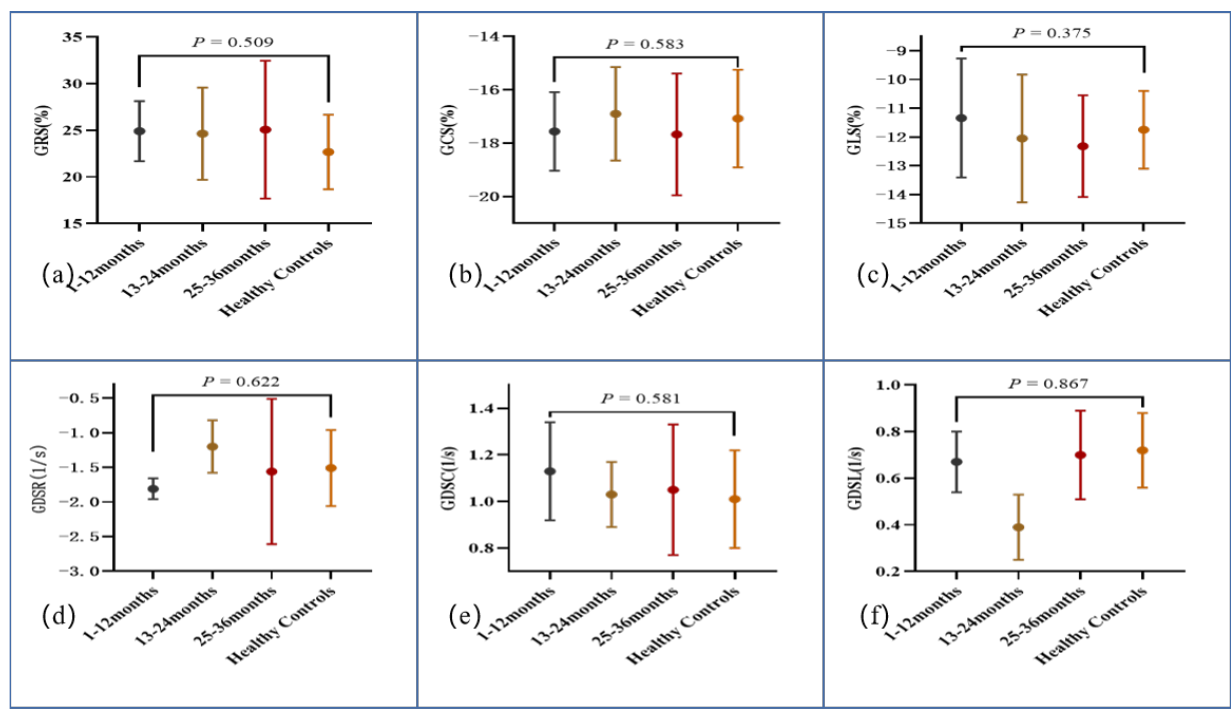
Figure 4. Plots for comparison of left ventricular global radial strain ( a ), global circumferential strain ( b ), global longitudinal strain ( c ), global diastolic strain rate radial ( d ), global diastolic strain rate circumferential ( e ), and global diastolic strain rate longitudinal ( f ). Table 5. Correlation between CD4+ T-cell counts and CMR